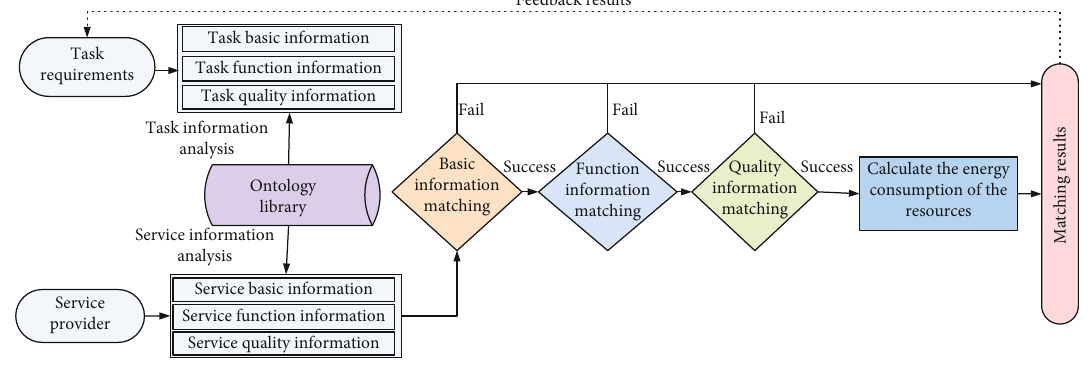
Figure 4: Intelligent matching framework. Table 1: Fuzzy number table corresponding to linguistic term set